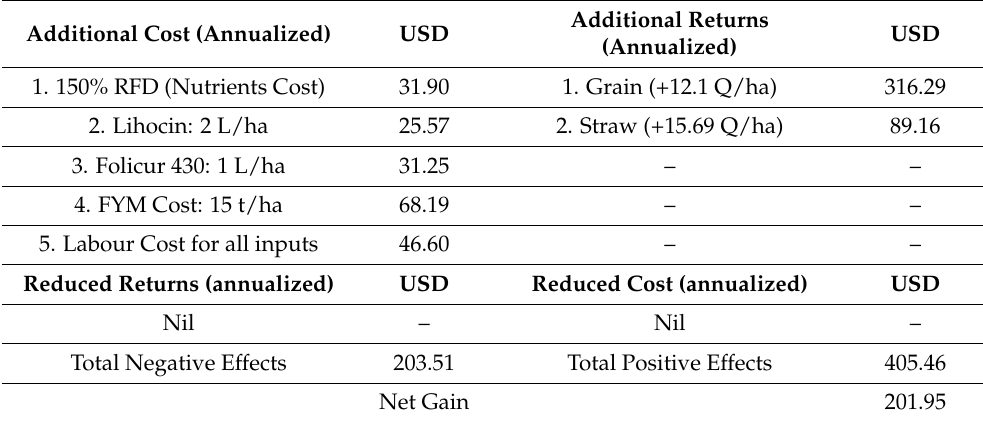
Table 5. Partial budgeting estimates for